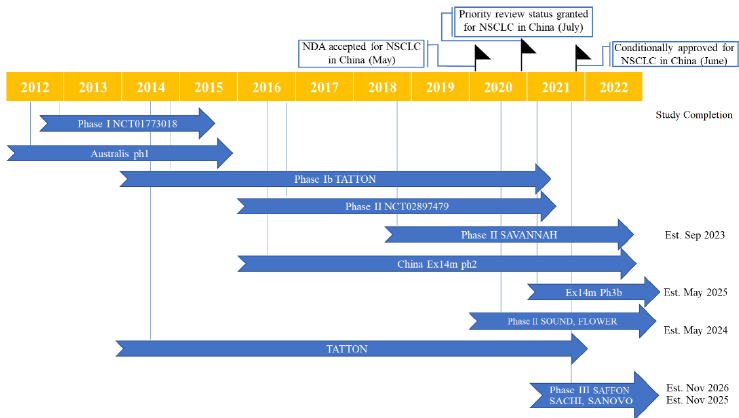
Figure 3. Key milestones and clinical trials in the development of savolitinib for non-small cell lung cancer.